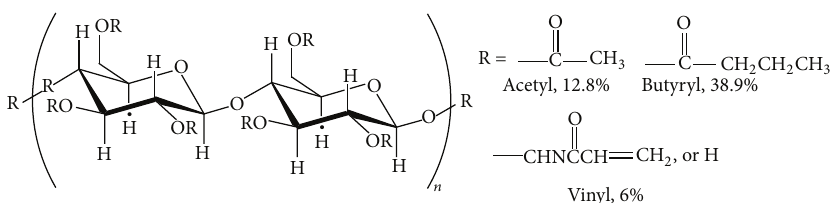
Figure 1: Structural representation and composition of commercial